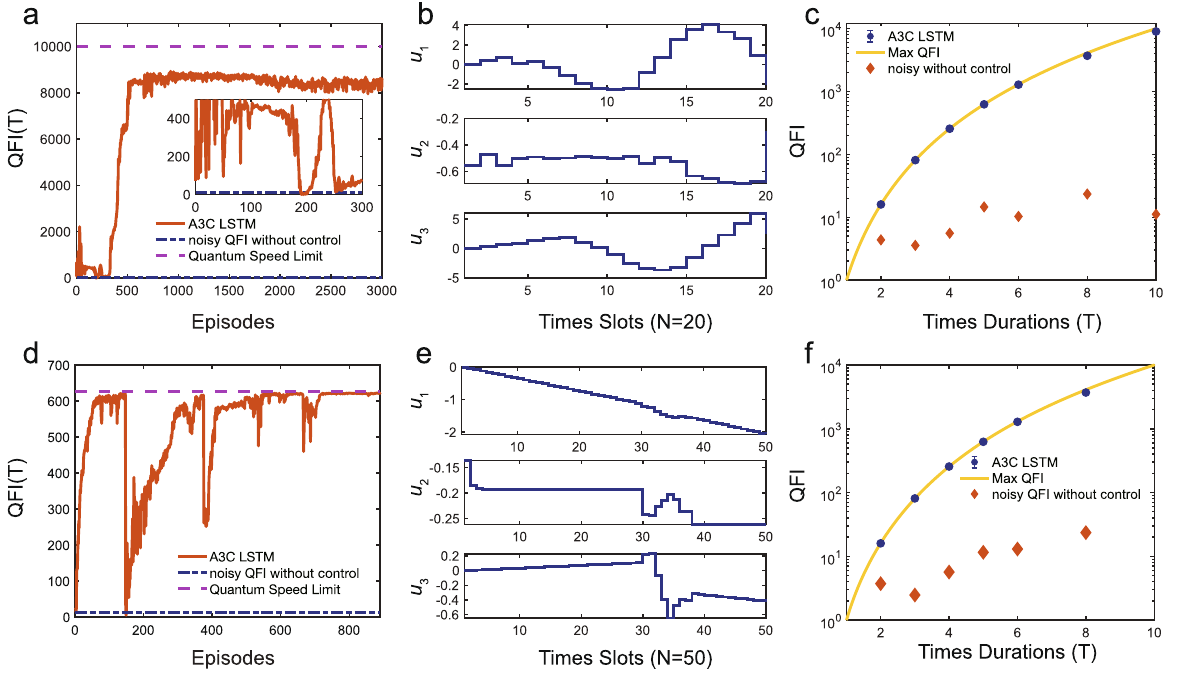
Fig. 8 Results of estimating ω under noisy dynamics with parameters A = 1, ω = 1. The fi rst row is for DP noise where T = 10, Δ t = 0.5, γ = 0.1 and the second row is for SE noise where T = 5, Δ t = 0.1, γ + = 0.1, γ − = 0. a and d shows the learning process. b and e show the optimized control signals over all episodes. c and f display the QFI value with different time durations. Error bar is the standard error of the